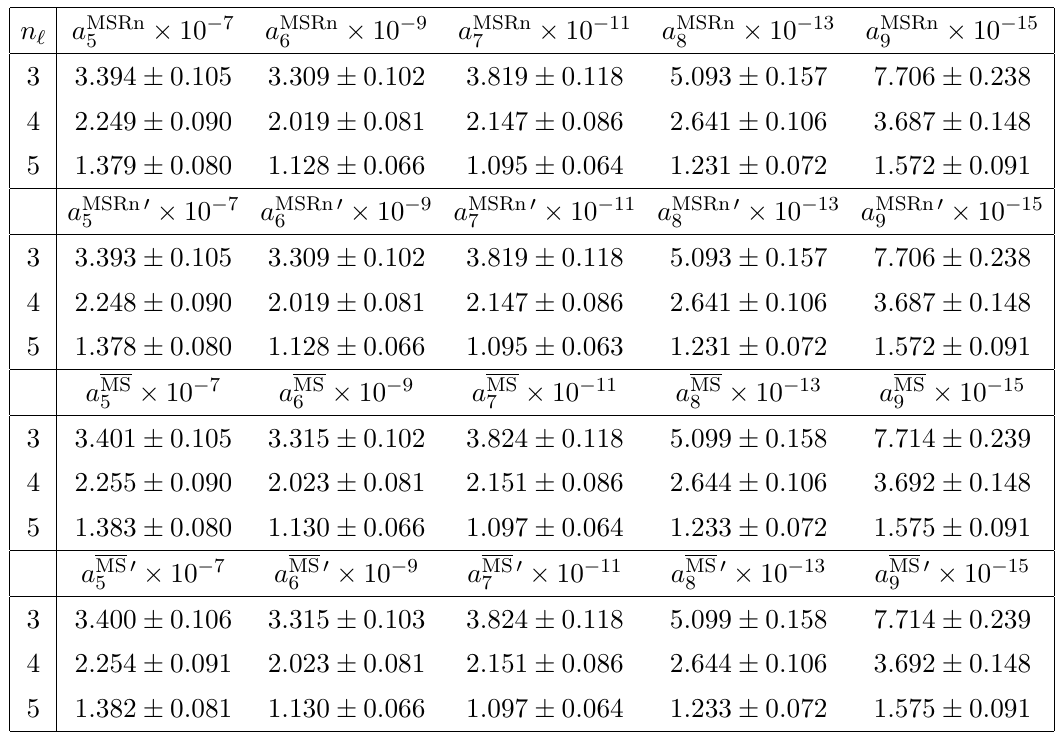
Table 2. Numerical estimates for the perturbative coe(cid:14)cients a MSRn (MSRn-pole mass relation n in eq. (2.3)) and a MS [MS-pole mass relation in eq. (2.1)] for 5 (cid:20) n (cid:20) 9 and n ‘ = 3 ; 4 ; 5 using n formulae (4.20) and (4.21) for their asymptotic high-order behavior. The quoted errors arise from (cid:21) and (cid:17) variations in the interval [0 : 5 ; 2] and the central values are the mean of the maximum and minimum values in that